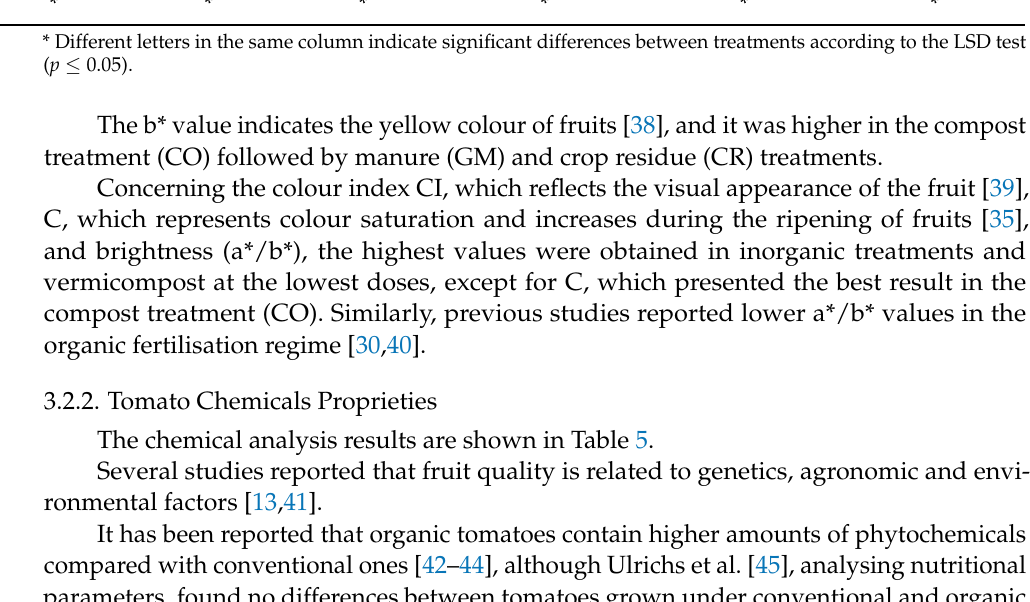
Table 5. Effect on fruit chemicals composition in tomato crop fertilised with inorganic fertilisers (IF), goat manure (GM), crop residue (CR), compost (CO), and vermicompost at 3 (V3) and 9 kg m − 1 (V9).